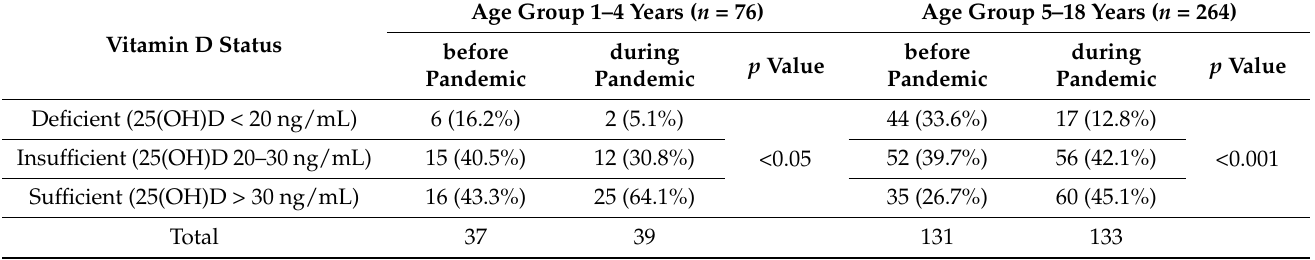
Figure 3. Box plot showing the level of vitamin D (25(OH)D, ng/mL) before and during COVID-19 restrictions. Data are expressed as median, p < 0.001. Table 3. Vitamin D deficiency before and during the COVID-19 pandemic, according to age.